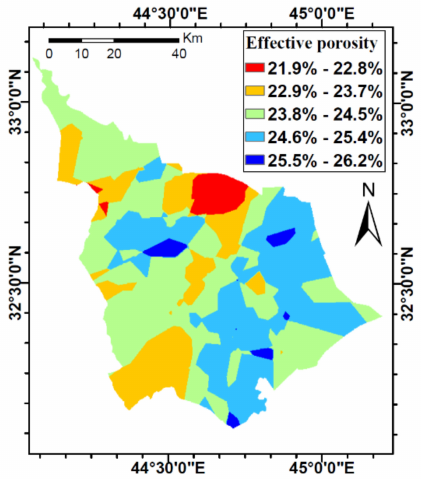
Figure 8. Groundwater elevation map within Babylon province.